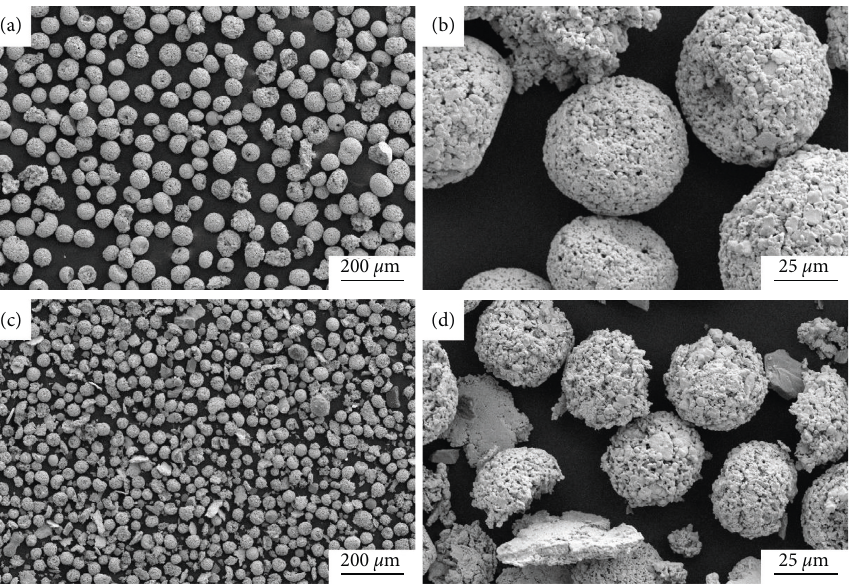
Figure 1: The morphology of powder and mixed powder. Table 1: Material design composition.